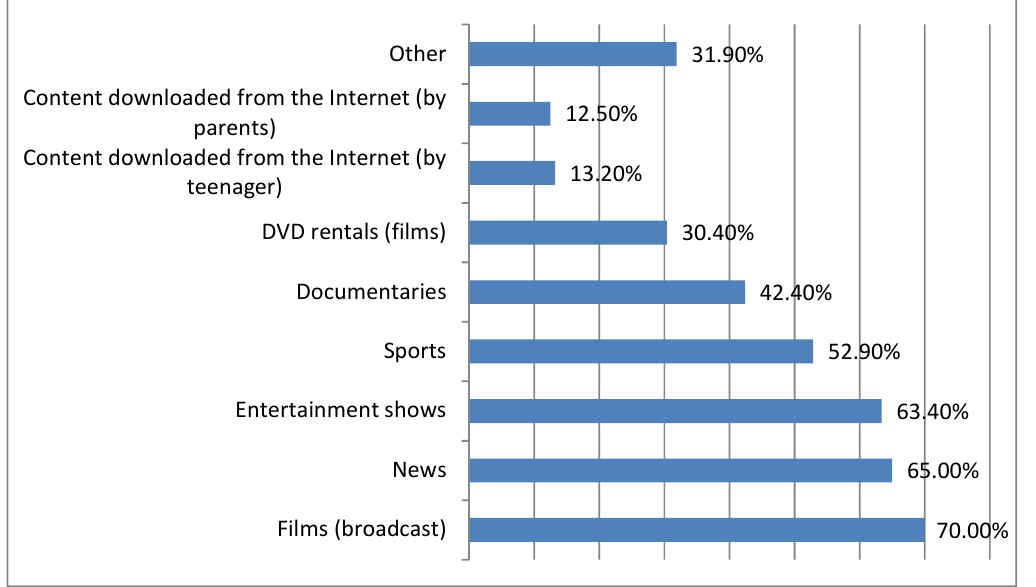
TV programs watched together (parents and children) at the same place and time Source: data extracted from online survey sent to parents.